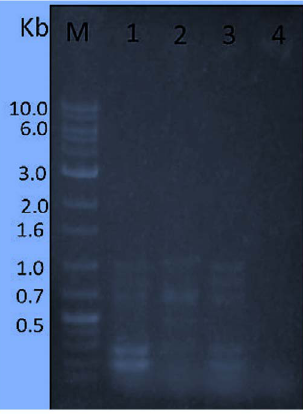
(lane 3) has the same number of bands and the same molecular weights as the wild type strain.